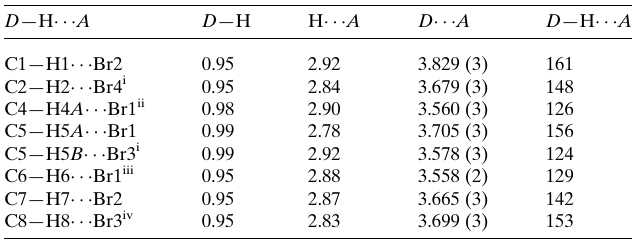
Table 1 Hydrogen-bond geometry (A˚ , (cid:3) ).